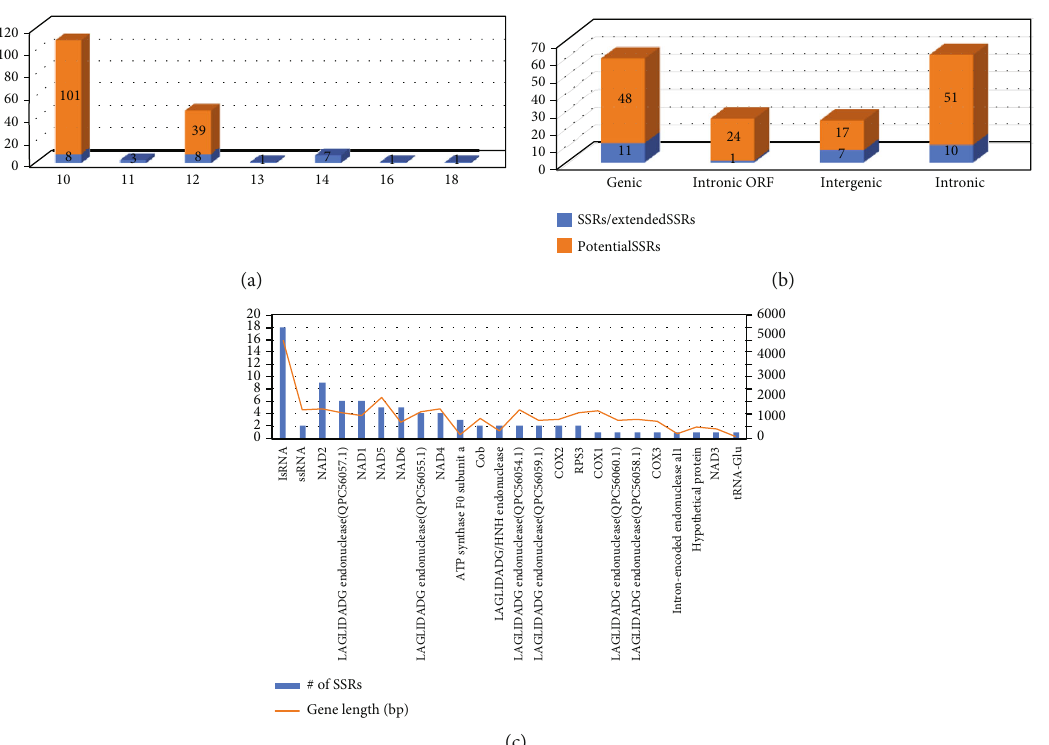
Figure 4: Comparative analysis of simple sequence repeats on mitogenome of WBPH fungal endosymbiont. (a) Number of SSRs, extended SSRs, and potential SSRs along with its length. x -axis indicates SSR length (bp), and y -axis means the number of SSRs. Blue-colored bars indicate SSRs and extended SSRs, and orange bars mean potential SSRs. (b) Number of SSRs, extended SSRs, and potential SSRs based on positions, genic, intronic ORF, intergenic, and intronic. (c) Number of genic SSRs along with genes (blue bars) as well as length of genes (orange line). x -axis is genes containing SSRs, and y -axis indicates the number of SSRs (left) and gene length (bp;